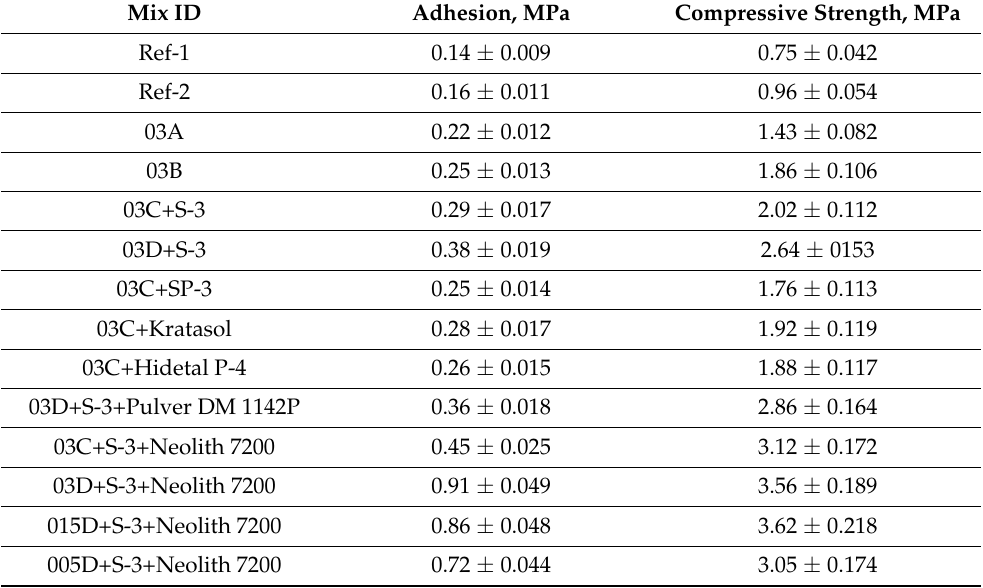
Table 10. Adhesion and compressive strength of the lime composites (28